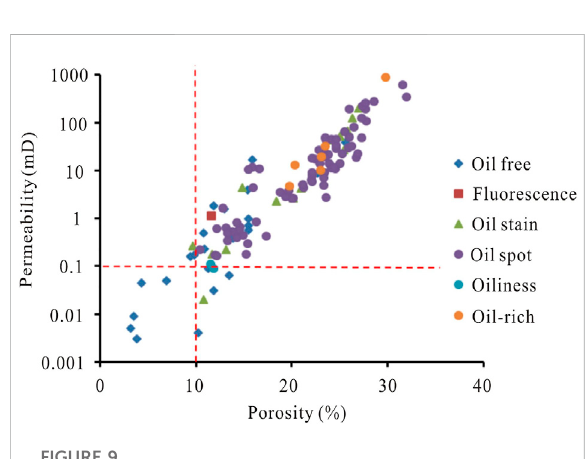
FIGURE 9 Relationship between oil content and physical properties revealed by the cores of the Quan 3